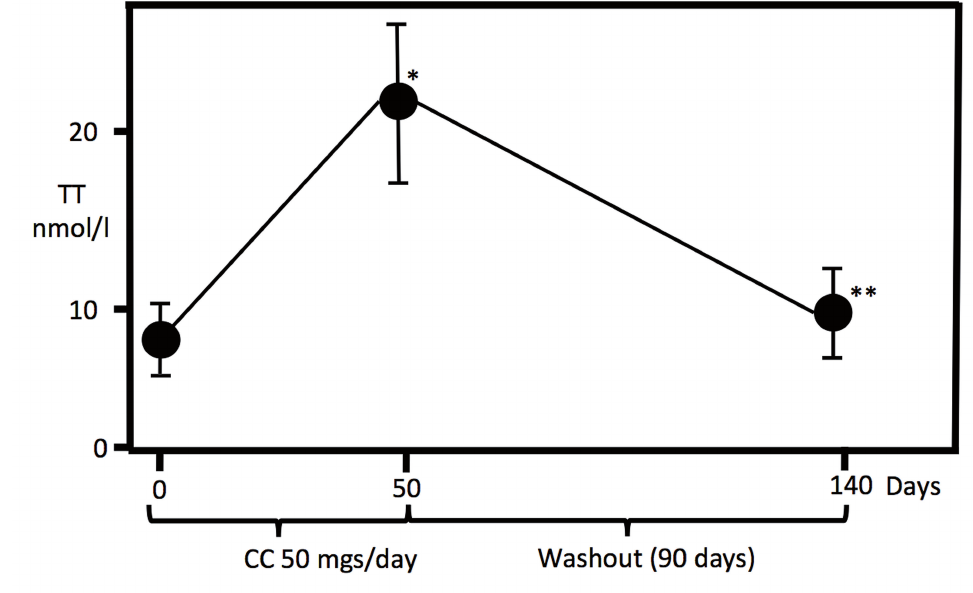
figure 1 - Total Testosterone (TT) levels at Day 0 (diagnosis), Day 50 (after clomiphene citrate (cc) treatment, 50mgs. daily), and Day 140 (90 days after ending cc